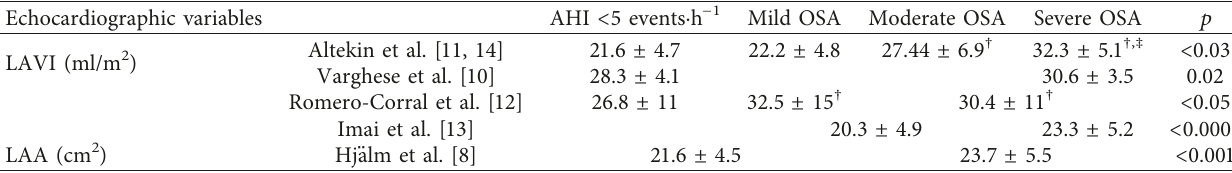
Table 1: Left atrial volume and area in relationship with OSA severity.